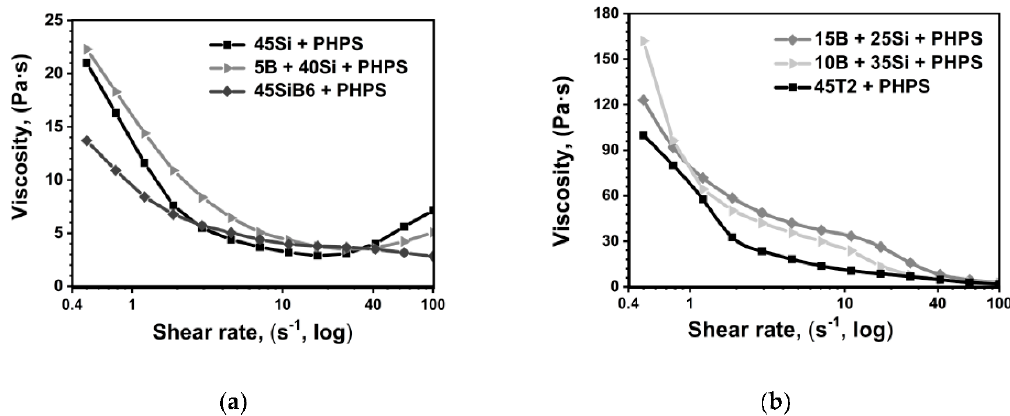
Figure1. Viscositycurvesoffillerloadedcoatingslurries: ( a )45Si, 5B + 40Si, 45SiB 6 systems; ( b )15B + 25Si, Figure 1. Viscosity curves of filler loaded coating slurries: ( a ) 45Si, 5B+40Si, 45SiB 6 systems; ( b ) 10B + 35Si, 45 T2 systems; measured at room 15B+25Si, 10B+35Si, 45 T2 systems; measured at room temperature.